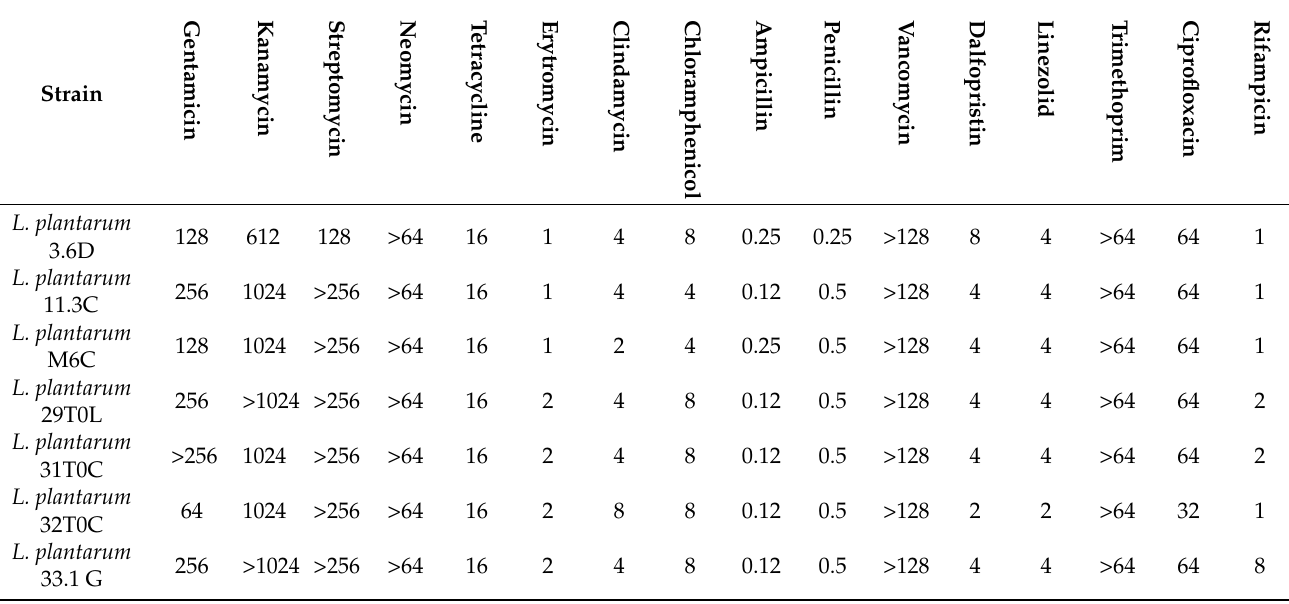
Table 3. Evaluation of minimum inhibitory concentrations (MIC, µ g/mL) of selected antibiotics against Lactobacillus and Bifidobacterium strains isolated from breast milk and used in the present